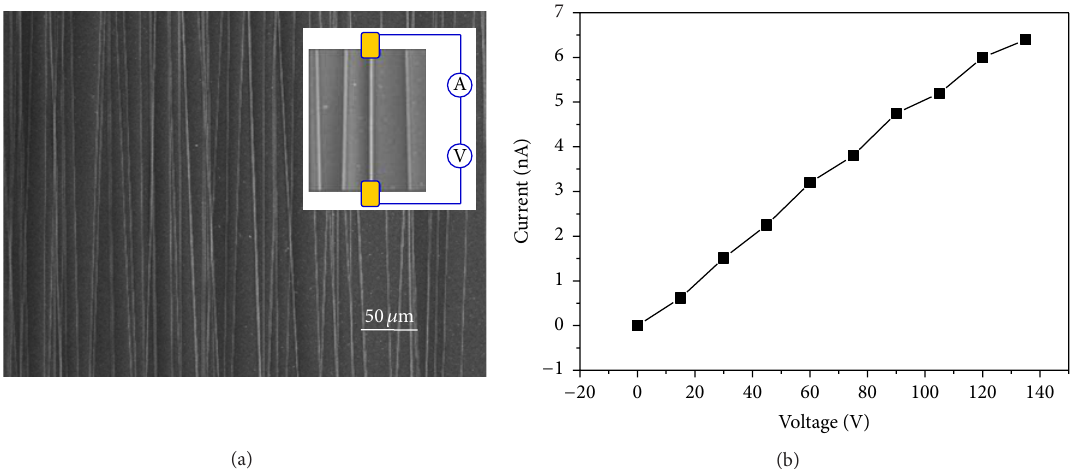
Figure 2: (a) SEM image of the aligned PEDOT:PSS/PVP nanofibers prepared by centrifugal electrospinning. The smaller picture displays schematic illustration of electrical conductivity measurement of isolated nanofibers by a two-metal-microprobe method. (b) I-V curve of isolated fibers.